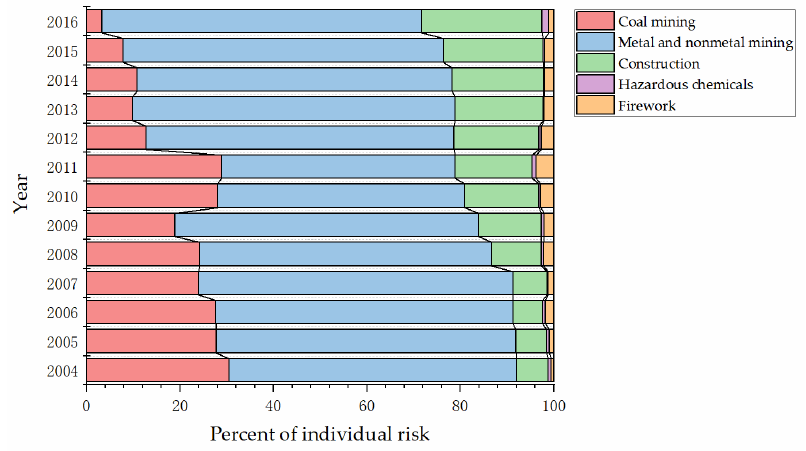
Figure 5. Percent stacked bar of individual risk of each high-danger industry to the whole.